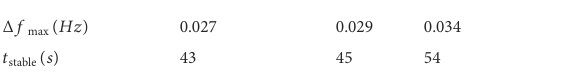
TABLE 3 Test results in case